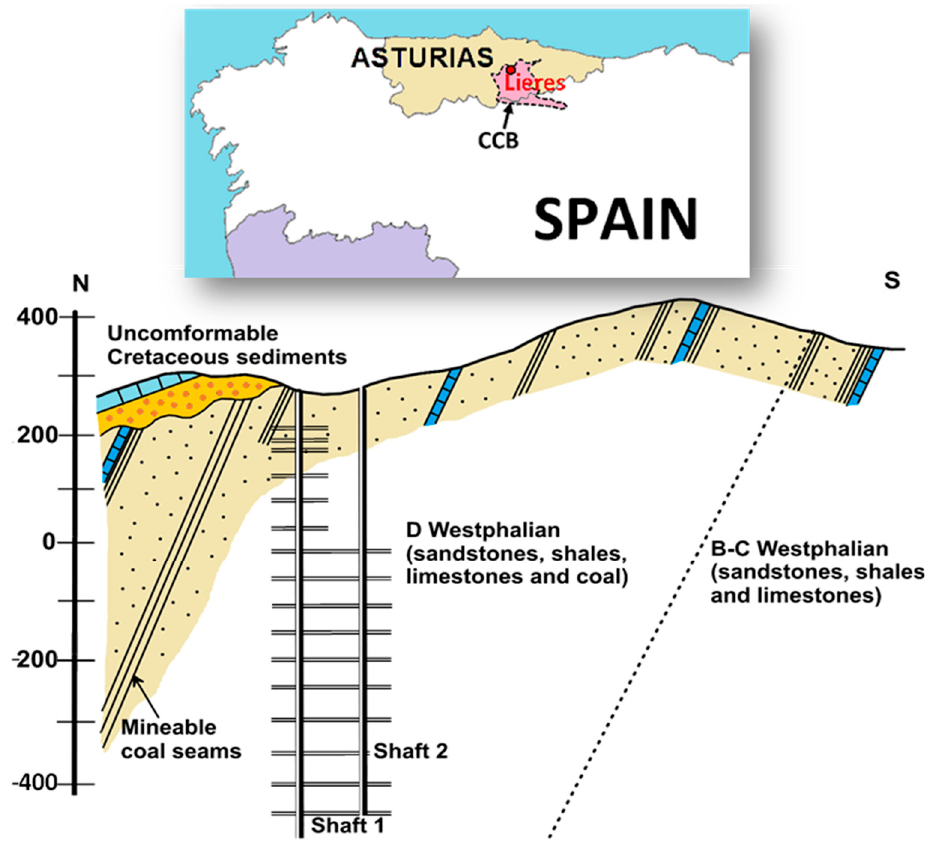
Figure 1. Location of the study area. North–south geological cross section through the Lieres mine.